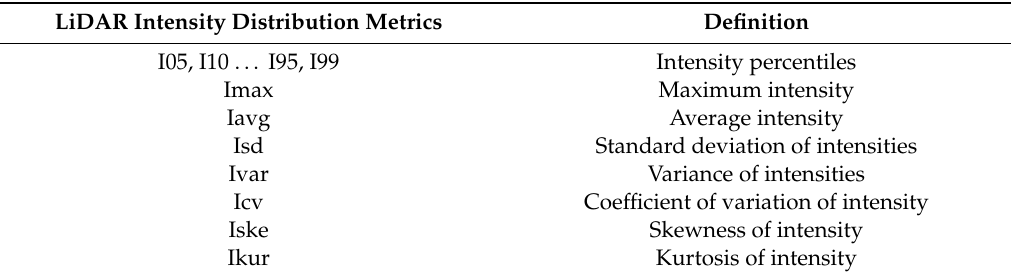
Table 3. The LiDAR-derived intensity distribution metrics calculated from GR and NIR channels